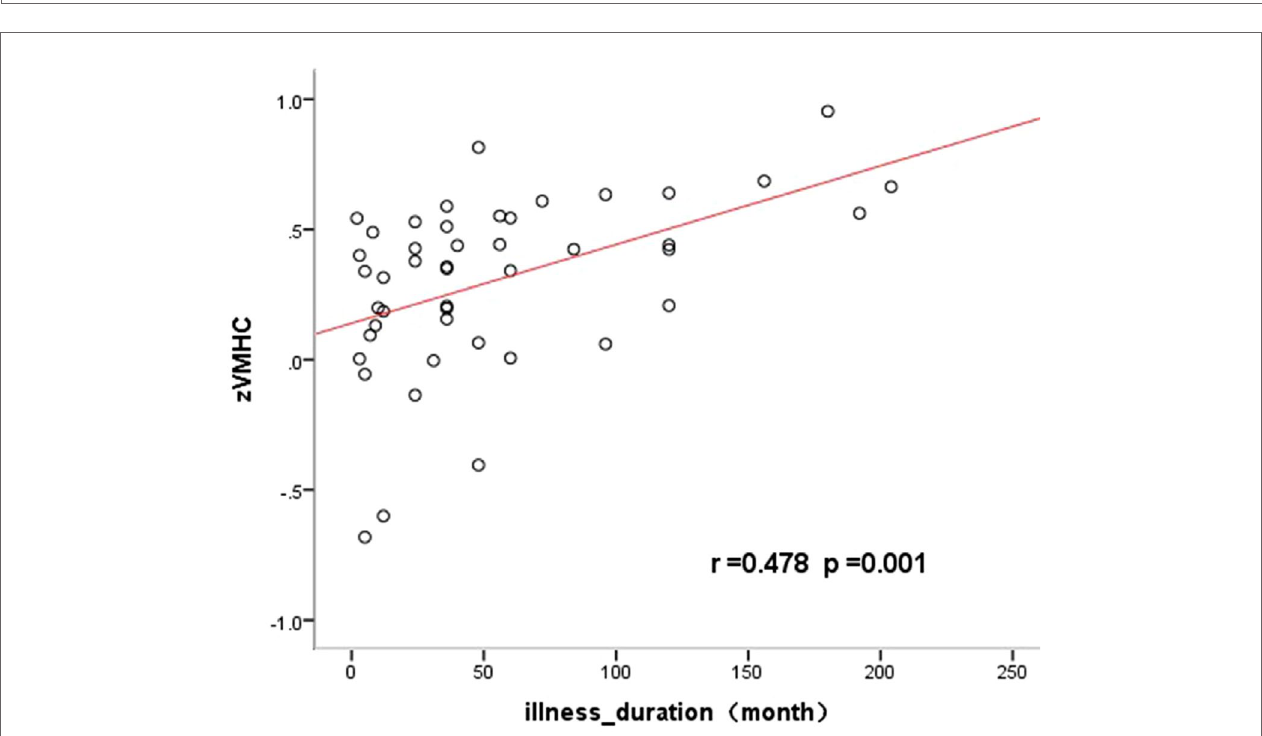
FIGURE 2 | Regions exhibiting significantly positive correlations between VMHC value and illness duration in OCD patients are presented as color overlays. The color bar represents R values. L: left; R: